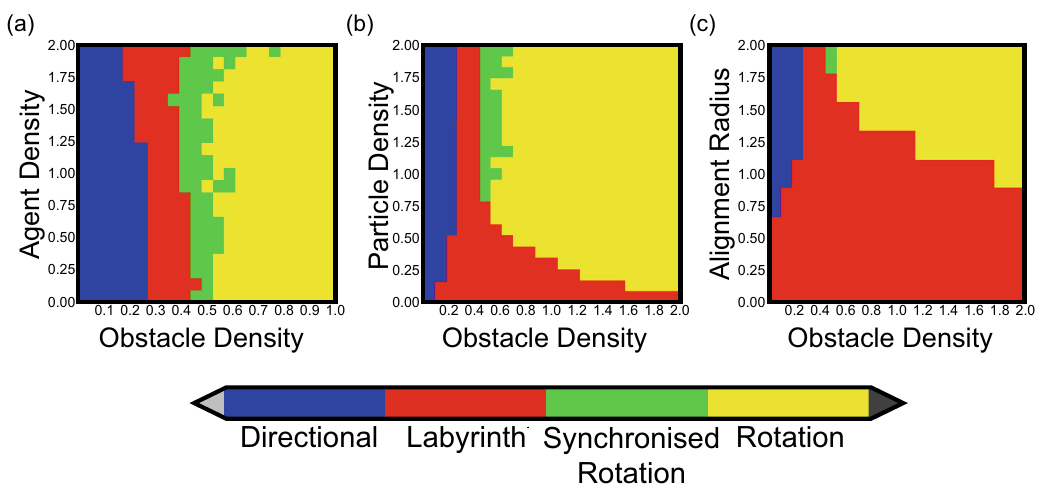
Fig. 6 Diagrams visualising the parameter sets for which a given motion state is obtained. The results are shown for 60 x 60 box size and obtained for periodic boundary conditions. In each panel ( a ), ( b ), and ( c ), the parameters — except the parameter along the Y -axis — are the same as those in Table 1. Panel a indicates that obstacle density dominates shot noise since there is no relevant change in the behaviour over much of the region of the shot noise values. Panel b shows the trade between the particle and obstacle densities. It shows that a dense medium is needed to see synchronised rotation. Panel c resembles panel ( b ) since the alignment radius is related to an effective particle